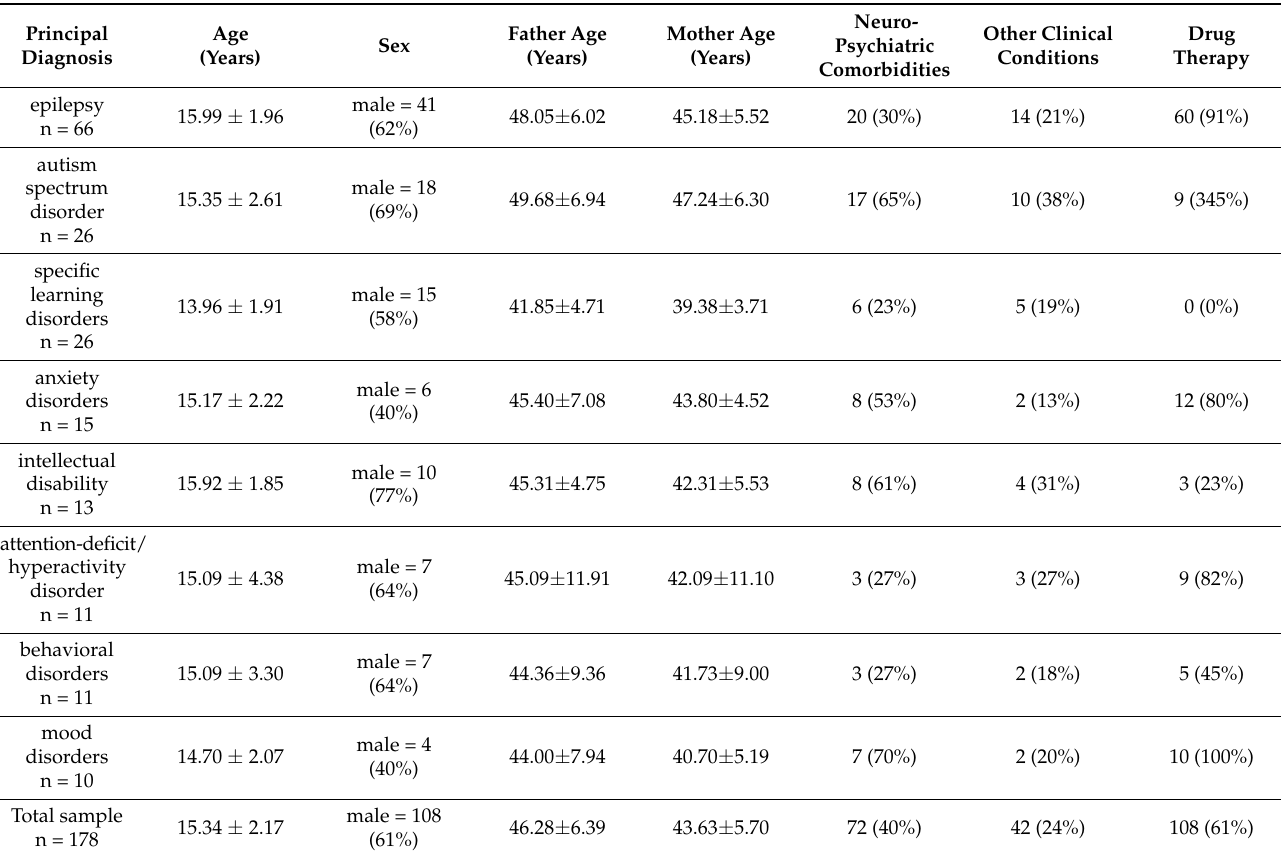
Table 2. Socio-demographic and clinical features of the subsample and total